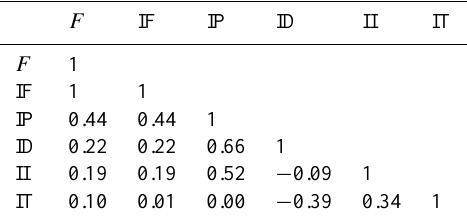
Table 4. Cross-correlation coefficient of monthly time series of monthly index of floods (IF) with indexes of precipitation (IP), wet days (ID), precipitation intensity (II), and temperature (IT) with variable m -month ( m = 1 , 2 , 3 , 6 , and